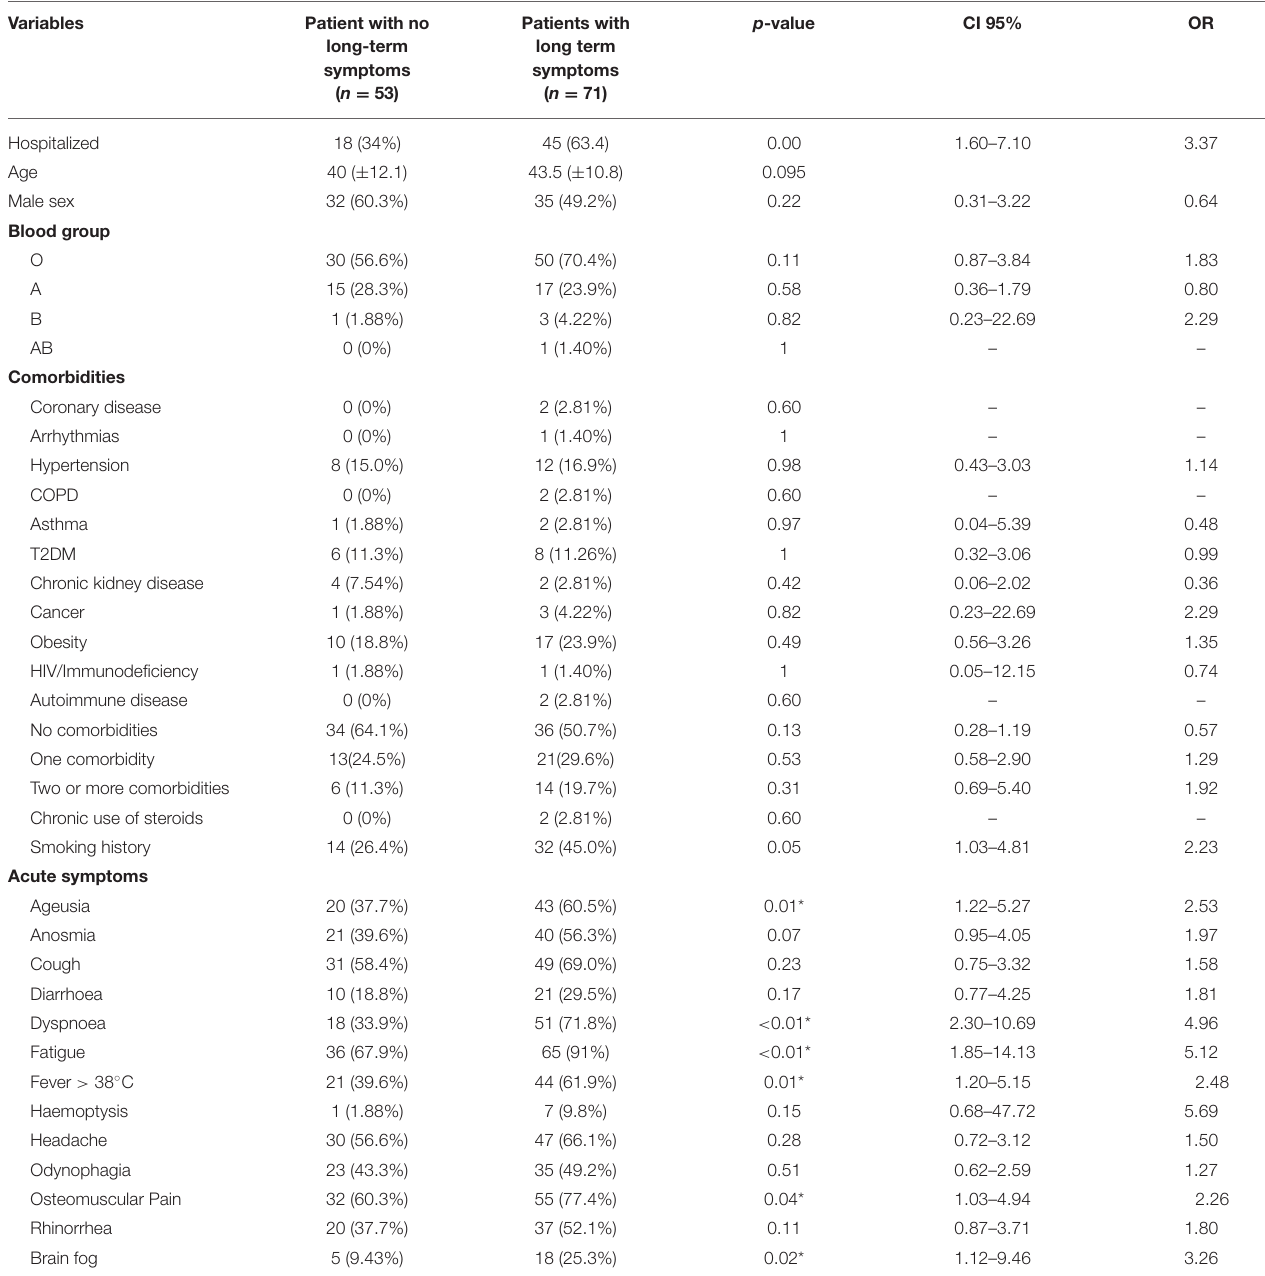
TABLE 3 | Demographic and clinical characteristics in patients with and without long-term COVID-19 symptoms.